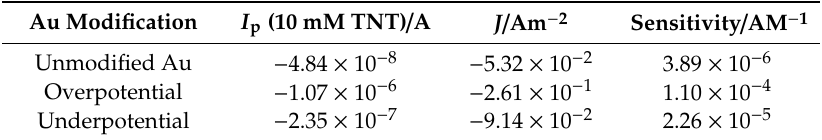
Figure 6. Cyclic voltammetry (CV) for the reduction of 2,4,6-trinitrotoluene (TNT) (1–10mM) in [C 4 mim] [NTf 2 ] on ( a ) a recessed Au MATFE, ( b ) Au underpotential modWE and ( c ) Au overpotential modWE at a scan rate of 100 mVs − 1 . Grey line is the response in the absence of TNT. The insets show background-subtracted calibration plots of peak current vs. concentration along with the line of best fit. Plots of absolute current vs. TNT concentration are shown in ( d ) on an unmodified Au MATFE ( ■ ), Au overpotential modWE ( ● ), and Au underpotential modWE ( ▲ ). The sensitivity of the electrodes improved almost 30 times on the overpotential Au modWE, with the underpotential modWE improving almost 10 times, (Table 2) thus demonstrating the advantage of modification by electrodeposition. This is much larger than the electroactive surface area enhancements of ~2.5 to 4 times shown in Table 1, suggesting that increased radial diffusion is occurring to the 3D structures. Table 2. Analytical parameters obtained for TNT reduction in [C 4 mim] [NTf 2 ]: reduction peak current ( I p ) for 10 mM TNT, current density ( J ) for 10 mM TNT, and sensitivity calculated for TNT peak 1 reduction (1–10 mM).